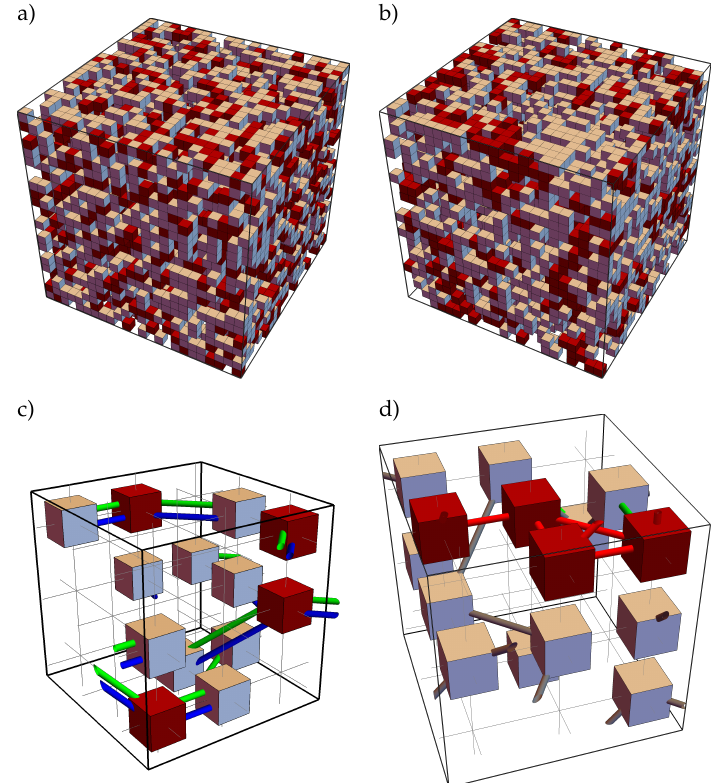
Figure 2. Exemplary snapshots of a reduced 3D cubical lattice of reduced size 24 × 24 × 24 at ( a ) t ini and ( b ) t fin for the parameter combination (I) (see Equation (9)) and two corresponding cutouts of size 6 × 6 × 6 ( c ): t ini ; ( d ): t fin ) that are magnified to show the actual existing bond vectors. The colors are chosen in analogy to Figure 1. In ( c ) only twin monomer structures are observed (see Figure 1b). As over reaction time bonds may cleave and form, a final structure emerge as depict in ( d ), where a small organic (gray gray) and inorganic (red bonds) network emerge. Note that some initial bonds (green) may survive till the end. The origin of both sub cubes is at position { 6,6,6 } within the large 3D cubes. Note that to make it easier to differentiate between the bond vector types that are connected to the center of the beads, here they are plotted next to each